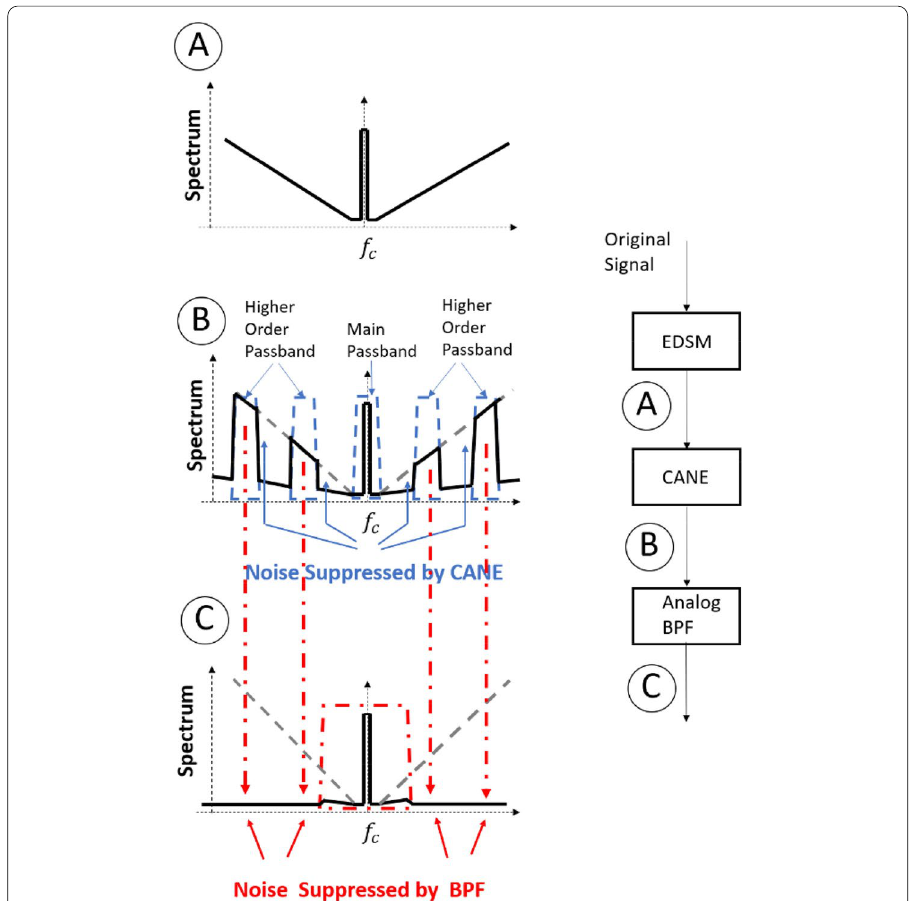
Fig. 2 Spectrum of bitstream modulated